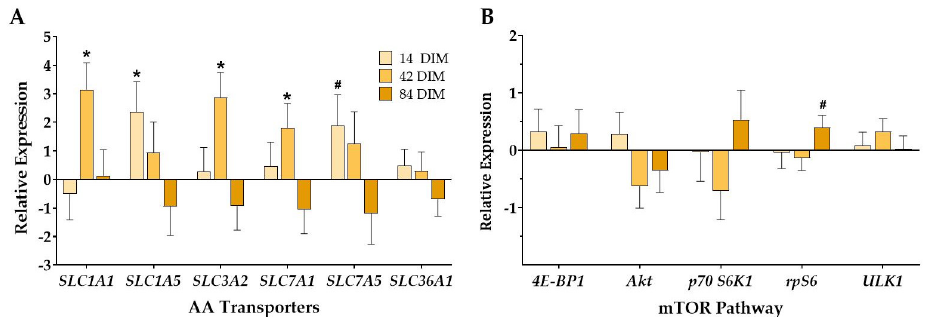
Figure 3. Effect of dry period heat stress on mammary tissue amino acid transporter ( A ) and mTOR pathway ( B ) gene expression. Cows were exposed to dry period heat stress (dry-HT, n = 6) or cooling (dry-CL, n = 6) for 46 days pre-calving. Mammary biopsies were collected at 14, 42, and 84 days in milk (DIM), and RNA was extracted from mammary tissue to analyze gene expression via qRT-PCR. Gene expression is reported as relative expression of dry-HT cows relative to dry-CL cows. * indicates p ≤ 0.05; # indicates 0.05 < p ≤